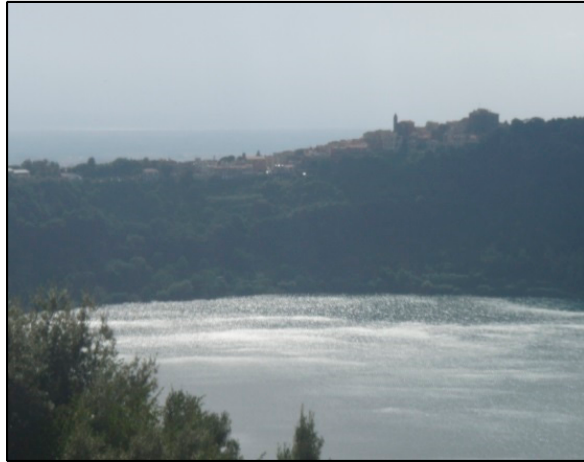
Figure 9. Lake Albano, Italy (Photo by M. Salgot).